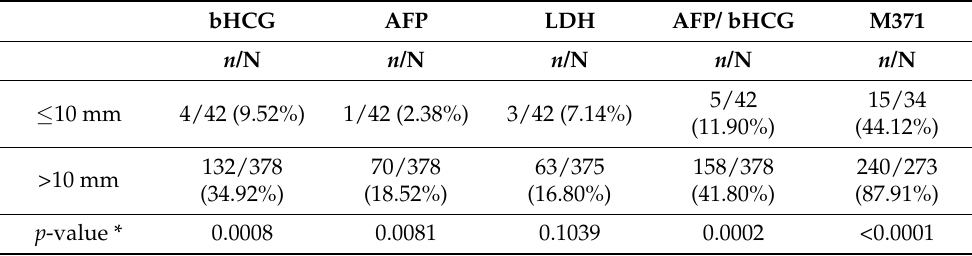
Table 13 delineates the expression rates of all tumour markers stratified by five tumour size categories in the entire study population and in the histologic subgroups of seminoma and nonseminoma (Figure 7). In all subpopulations, the expression rates of all tumour markers increased with increasing tumour sizes, except for AFP in the seminoma subgroup (Cochran–Armitage trend test, all except seminoma p < 0.0001; seminoma p = 0.9133). M371 revealed the highest expression rates in all size